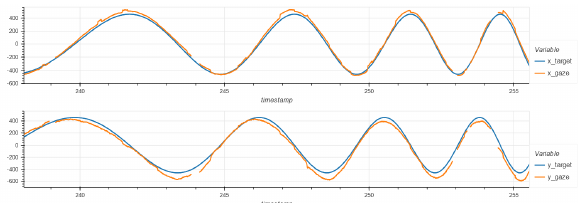
Figure 2. Smooth pursuit measurement on a portable eye tracking device operating at 200 Hz. This healthy participant followed a circular pattern, appearing sinusoidal when X- and Y-axis coor- dinates are analyzed individually. The blue line represents the path of the target while the orange line represents the partici- pant’s gaze trajectory. Gaps in data represent blinks. X-axis rep- resents time in seconds while the Y-axis represents distance in pixels. Original data acquired using a 200 Hz eye tracking device on a healthy 42-year-old male